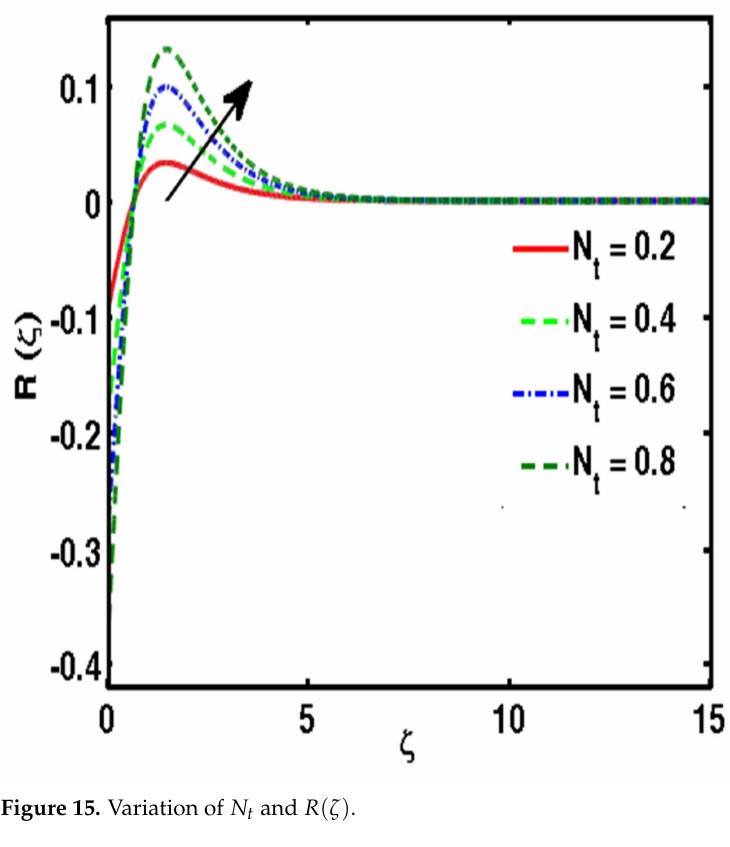
Figure 15. Variation of N t and R ( ζ ) .